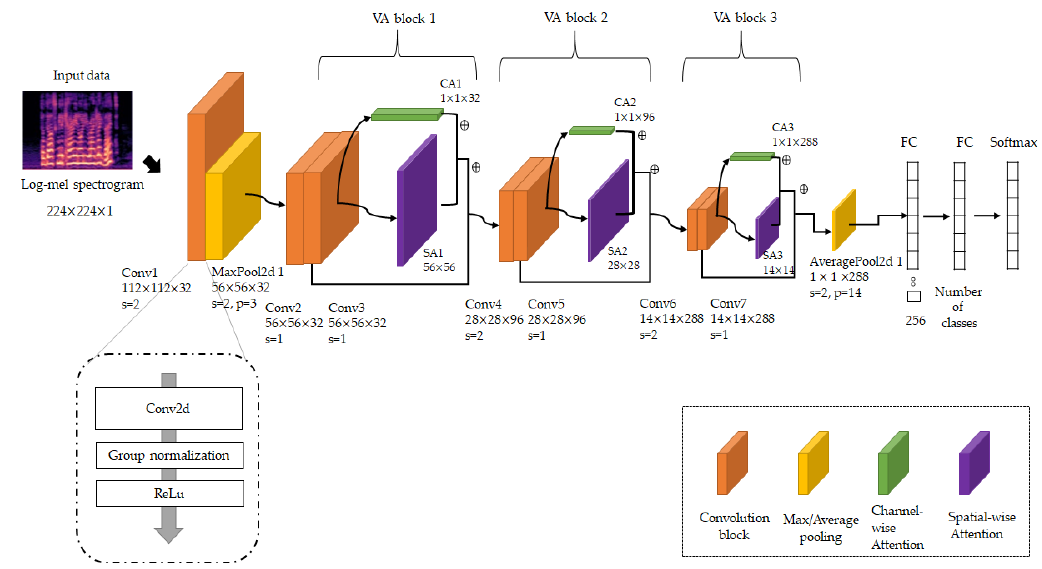
Figure 2. Architecture of the proposed pretrain VACNN model.